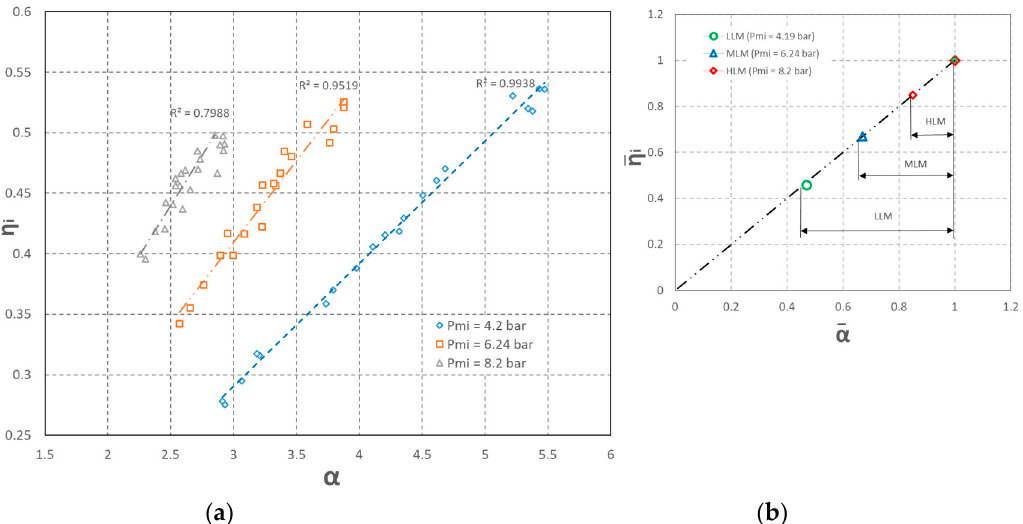
Figure 13. ( a ) Relationship between η i and α during dual-fuel engine operation with di ff erent loads of Figure 13. (a) Relationship between 𝜂 (cid:3036) and α during dual-fuel engine operation with different loads CCR NG and ϕ inj ( CCR NG = 0 to 0,8; ϕ inj = 1 to13 ◦ CA BTDC). ( b ) Relationship between η i and α of CCR NG and 𝜑 (cid:3036)(cid:3041)(cid:3037) (CCR NG = 0 to 0,8 ; 𝜑 (cid:3036)(cid:3041)(cid:3037) = 1 to13°CA BTDC ). (b). Relationship between 𝜂 (cid:3114) (cid:3365) and 𝛼(cid:3364) with dual-fuel engine operating on different loads of CCR NG and 𝜑 (cid:3036)(cid:3041)(cid:3037) . with dual-fuel engine operating on di ff erent loads of CCR NG and ϕ inj